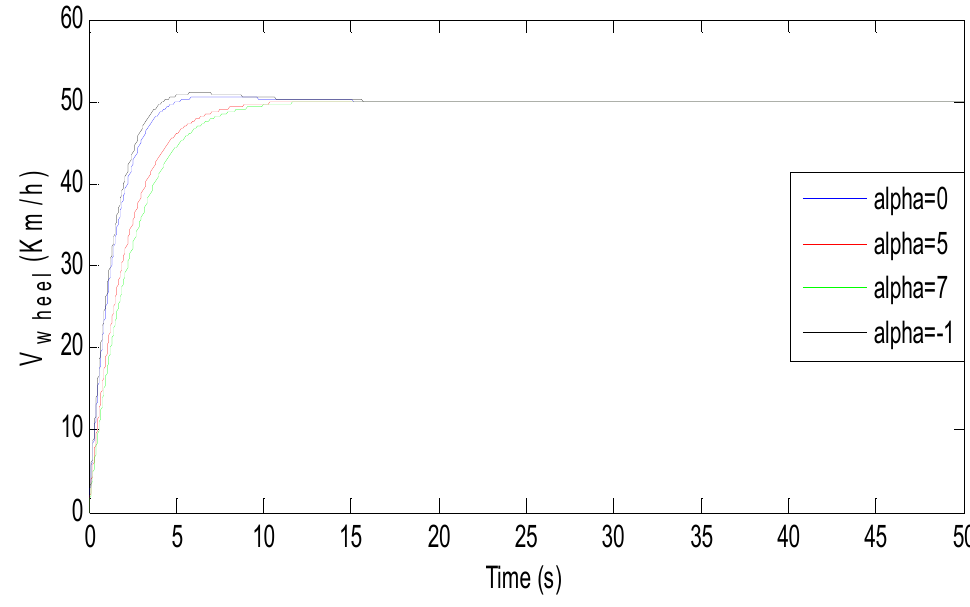
Figure 37. Effect of variation of surface-friction coefficient on BEV speed response.